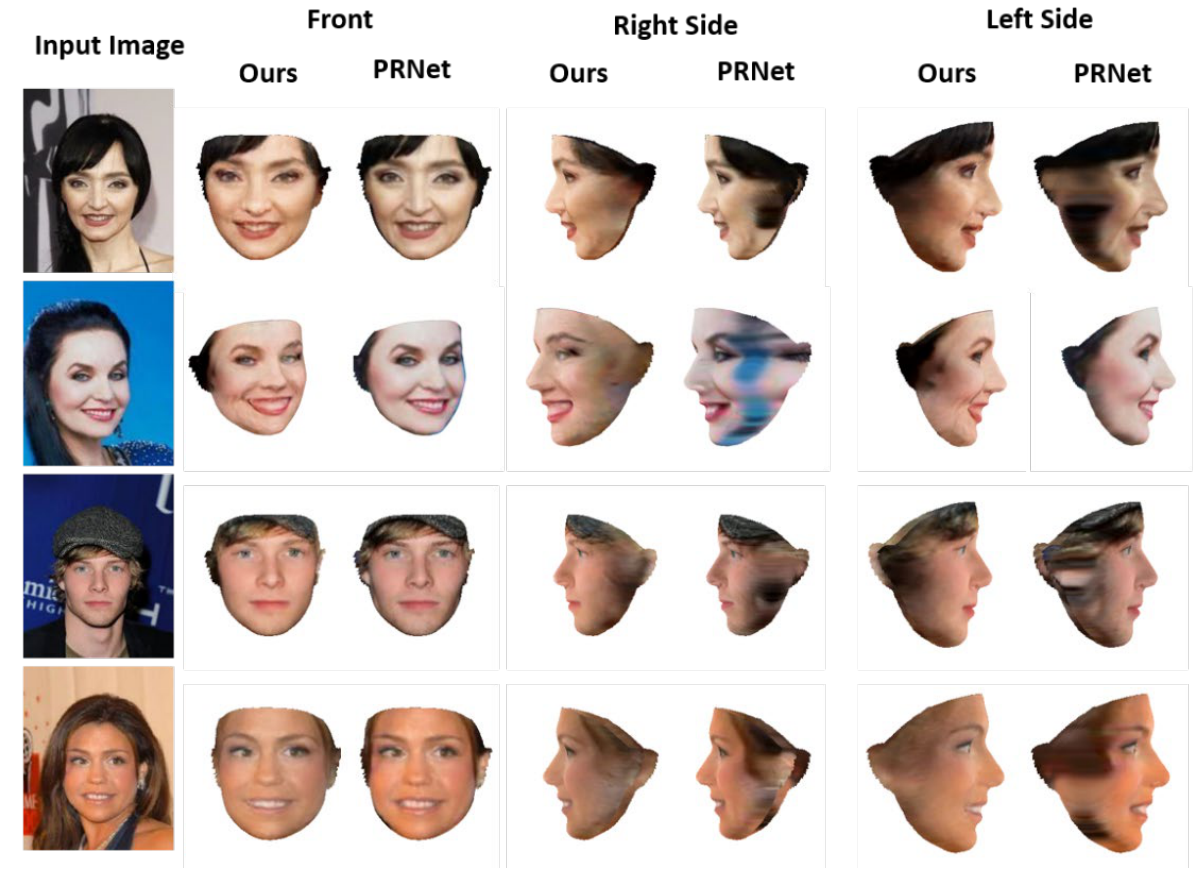
Figure 15. Texture generation result in Celeb-A dataset.